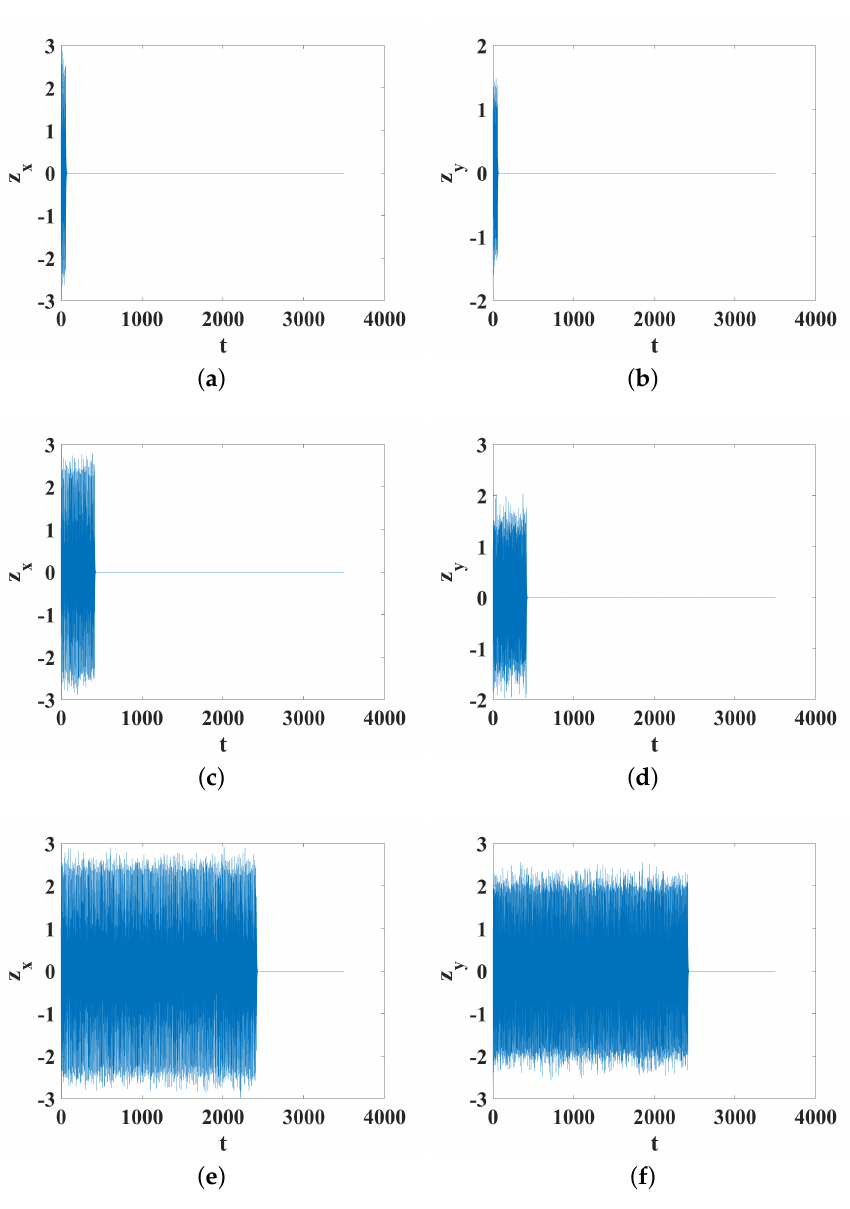
Figure 3. Accelerations z x , z y versus time evolution for a fixed initial condition and different values of the dispersion medium ( m = 6). ( a , b ) k 2 = 0.6; ( c ,( d ) k 2 = 0.7; ( e , f ) k 2 =